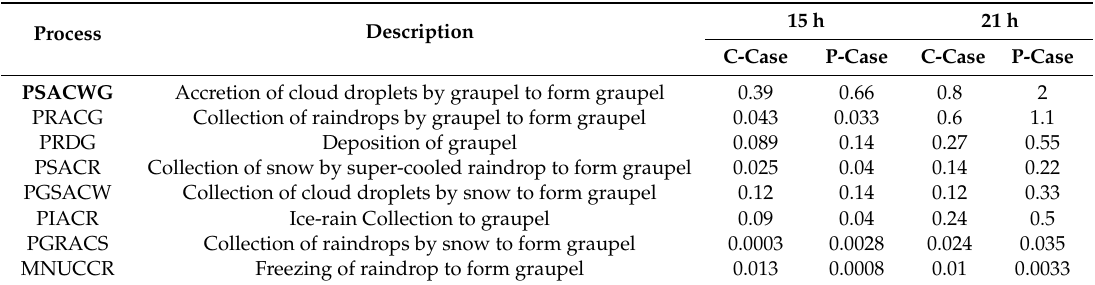
Table 2. Same as Table 1, but for graupel.